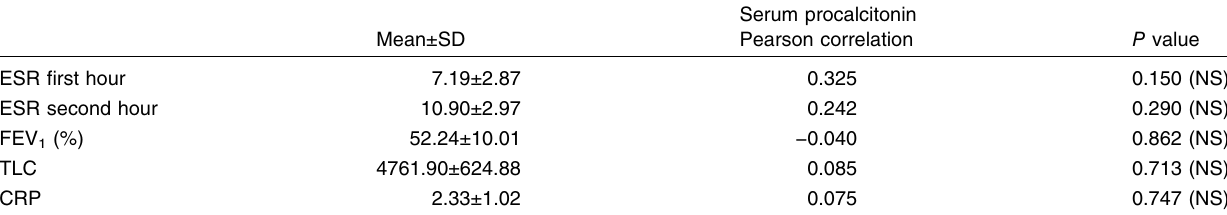
Table 23 Correlation between serum procalcitonin and different studied parameters in the nonbacterial group ( N = 21)